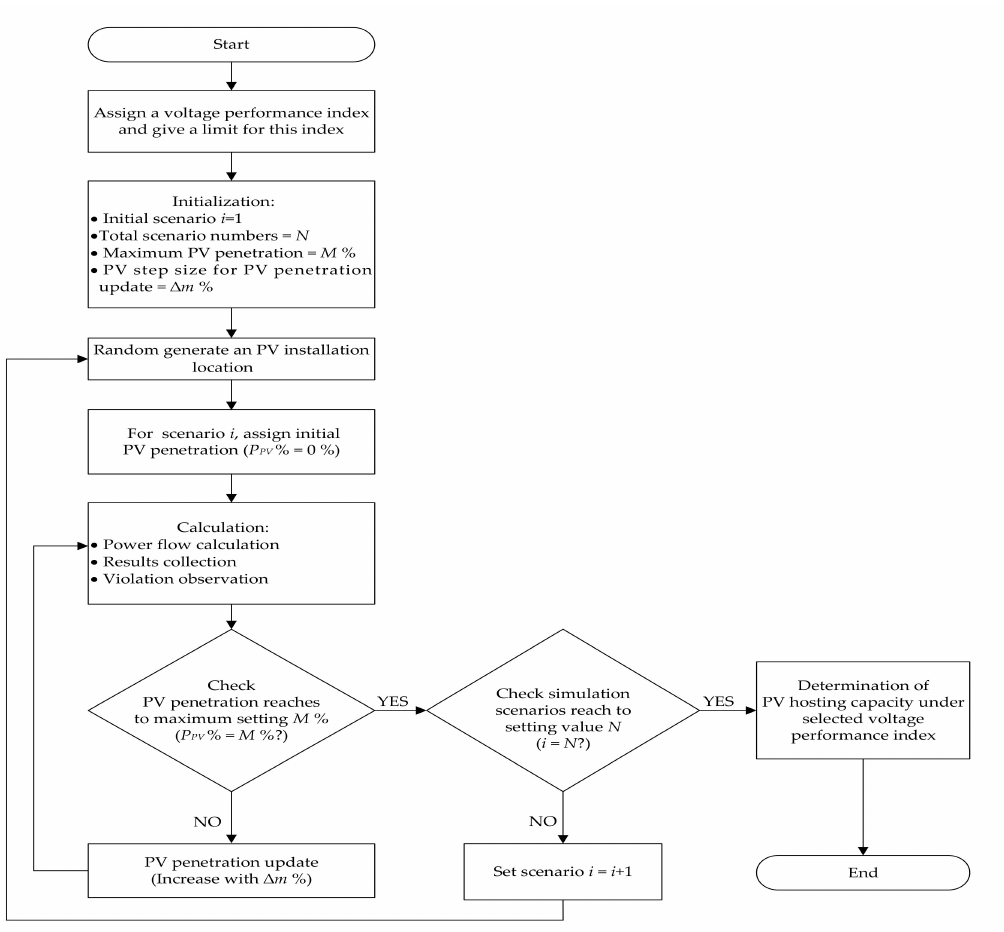
Figure 2. Flowchart of